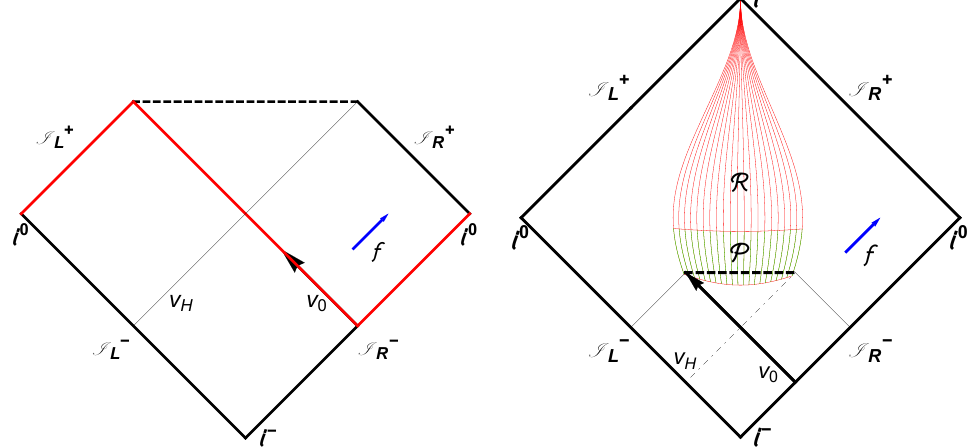
Figure 5. ( Left ) The usual 1+1 Penrose diagram for a Schwarzschild black hole with a singularity and information loss. The solid red line is the Cauchy surface over which integration is done. v H is the event horizon, and v 0 is the shock wave. The blue arrow, f , is Hawking flux. ( Right ) The 1+1 Penrose diagram for the case of a remnant with infinite life time (solid red lines), region R . In this situation the remnant end-state allows modes to pass through it (no information loss). Ultra-late time outgoing modes escape to null-infinity, I + , with a redshift dependent on the final asymptotic speed of the origin, 1 > ξ > 0. The green lines indicate the Planckian region P where non-trivial quantum spacetime effects are important. The dotted dashed gray line is the location of the original event horizon. The dashed black line, inside P , is the location of the original singularity, now hidden. The discontinuity occurs in P over the shock wave v 0 , as in the 3+1